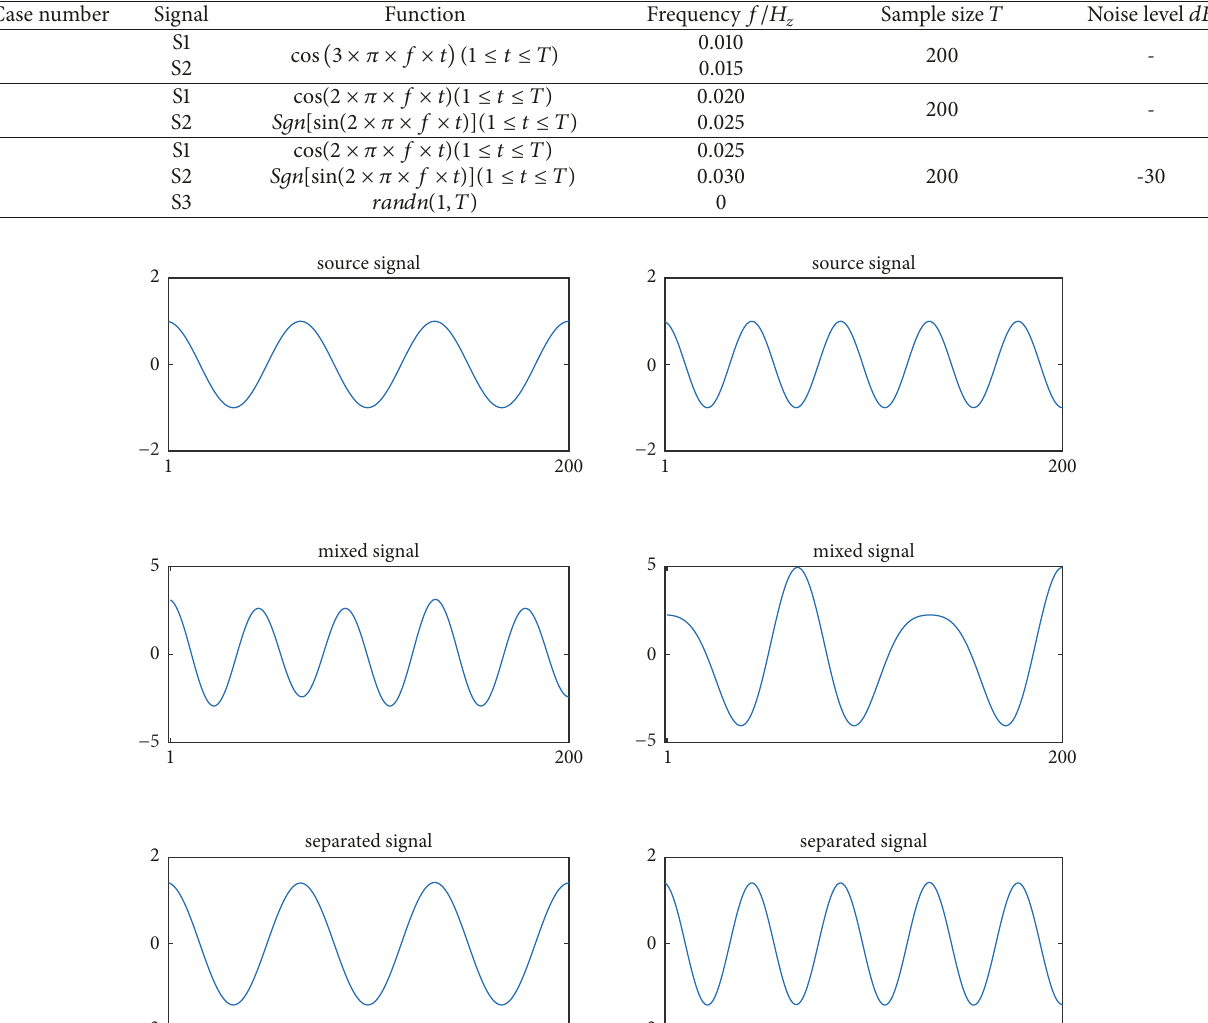
Table 1: Parameter settings for signal simulation.